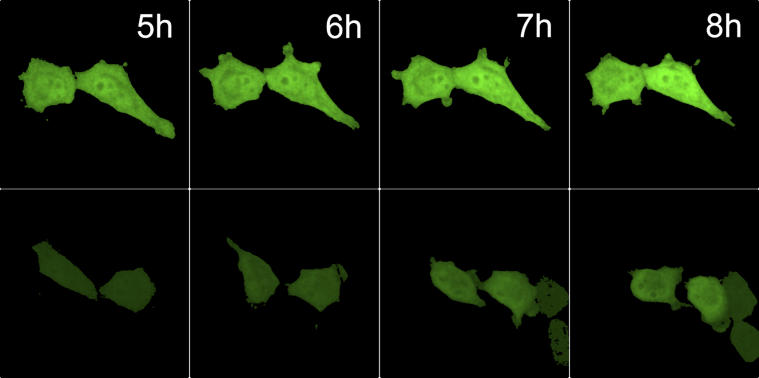
Cultured human cells produce ten times more green fluorescent protein from a GC-rich gene (top row) than from a synonymous GC-poor gene (bottom row).